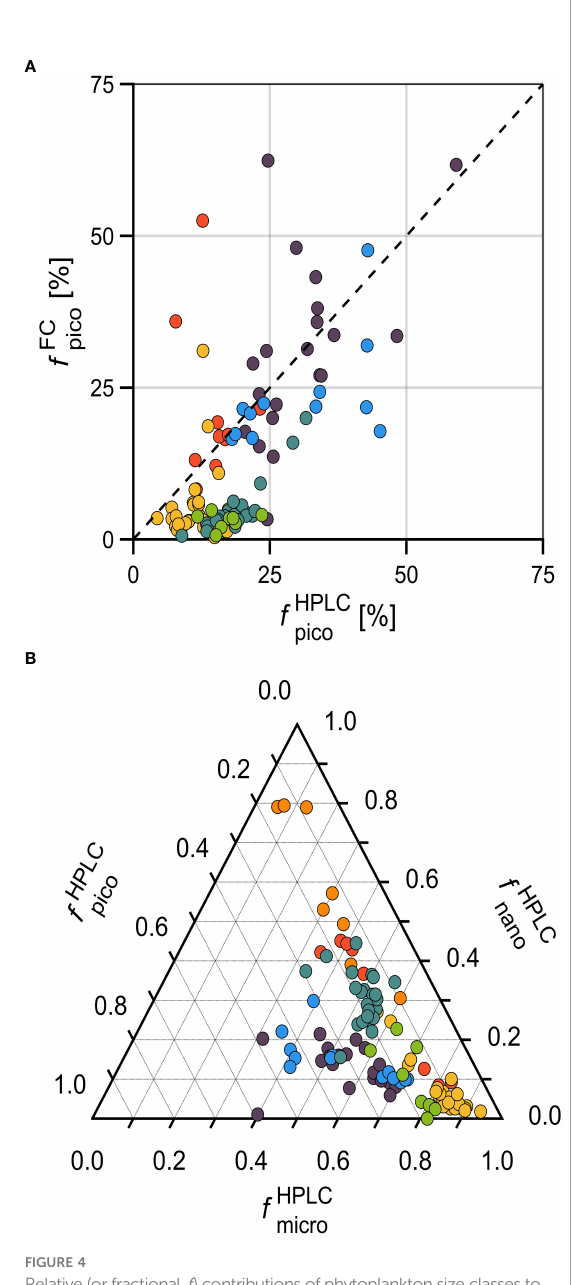
FIGURE 4 Relative(orfractional, f )contributionsofphytoplanktonsize classesto Chla, foreachphytoplanktoncluster. (A) Twomethodstoobtainthe picophytoplankton fractional contributiontoChla( f pico ): f FC pico and f HPLC pico (seetextfordetails). (B) Ternary plotof Thisapproach(pigment-based)considersaglobalrelationshipusing sevendiagnosticpigmentsasinputs(Uitzetal.,2006). Thecolorcode isthesameasinFigure